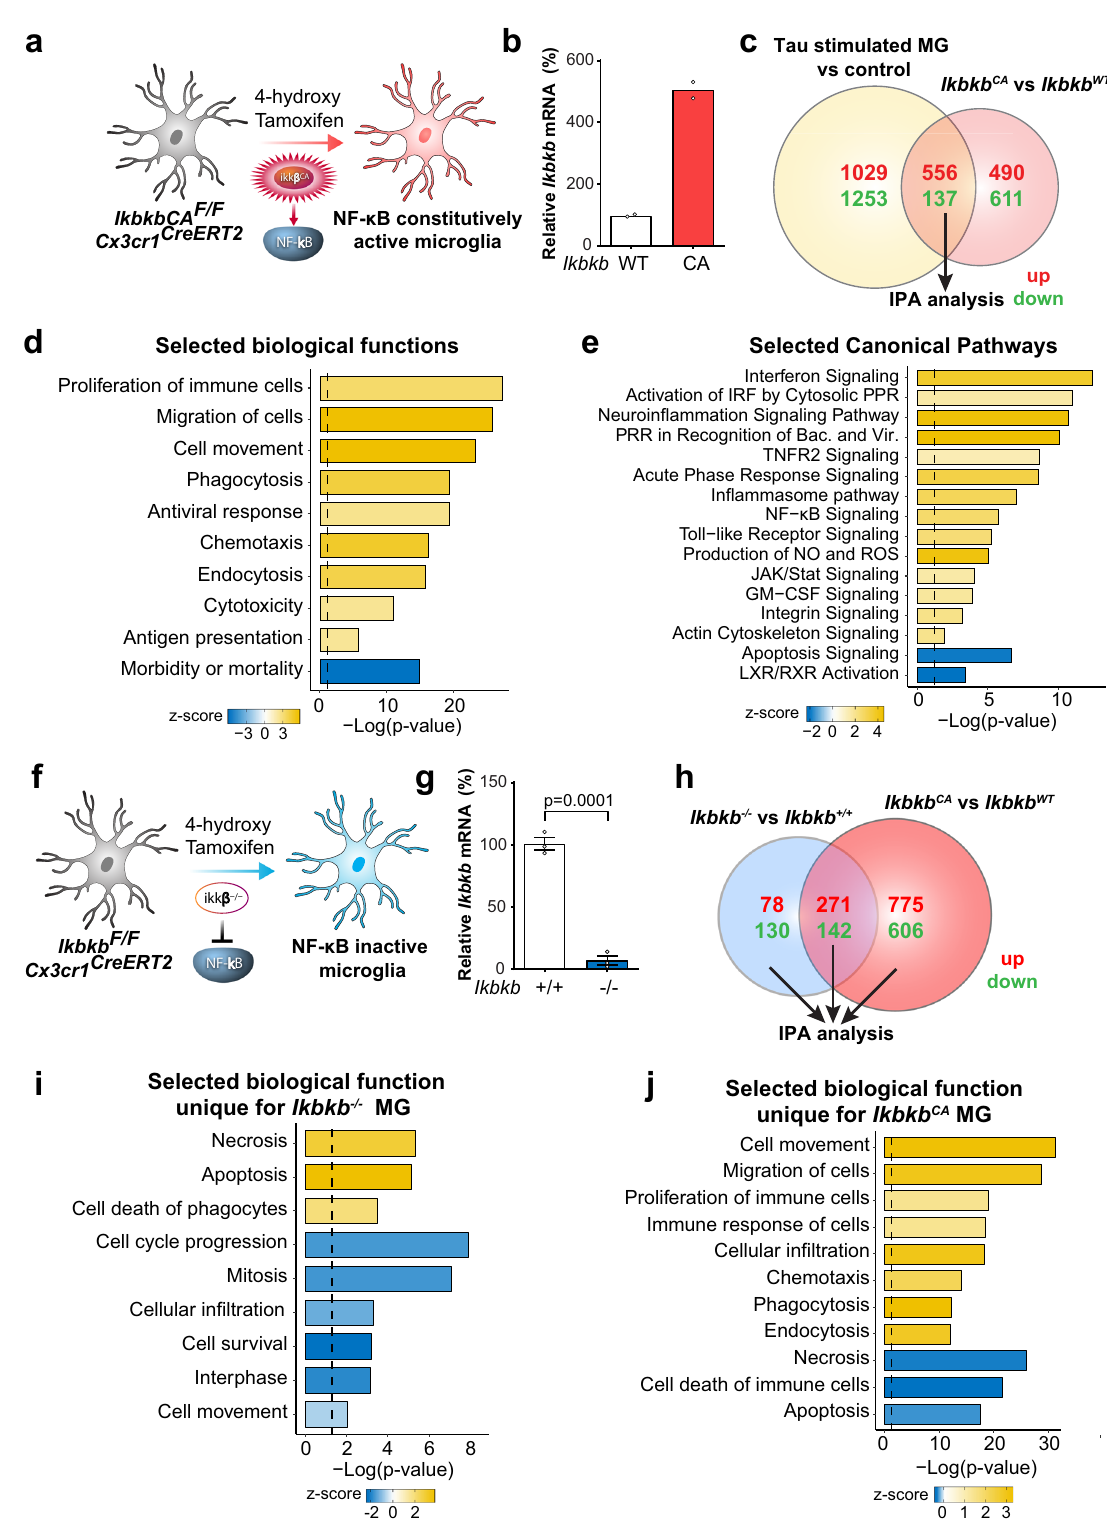
inhibitor PLX5622 (PLX) 48 , followed by inoculating with either brain extract from progressive supranuclear palsy (PSP) patients (Supplementary Fig. 4b) or synthetic K18/PL tau fi brils (Fig. 4a) unilaterally into the hippocampus. K18/PL tau fi brils-injected mice were continuously fed with PLX for one month to prevent microglial repopulation, which reduced the number of microglia by over 80% (Supplementary Fig. 4c, d). Depletion of microglia